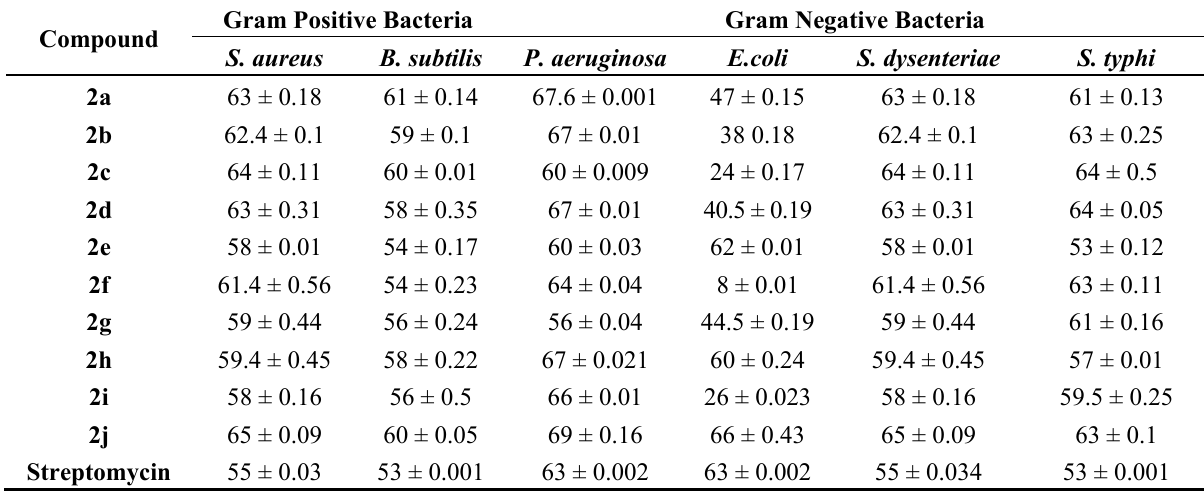
* Inhibition zone (in mm); data are expressed in the form of mean ± SD. Table 3. Antibacterial activity of synthetic compounds at 50 µg/mL *.